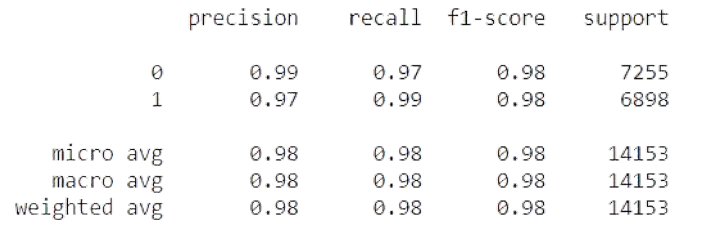
Figure 20. CNN with GlobalMaxpool